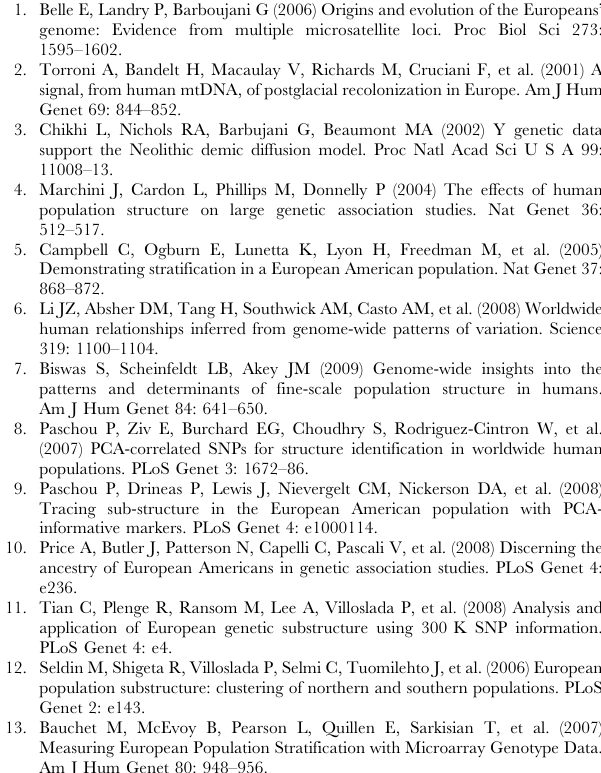
Figure S2 Distribution of the latitudinal (panel A) and longitudinal error (panel B) when using a panel of 927 SNPs selected on the POPRES samples to predict the coordinates of origin of the HapMap Phase 3 TSI samples. We consider as ground truth for the TSI samples our predictions using all 450K available SNPs. Found at: doi:10.1371/journal.pone.0011892.s002 (0.12